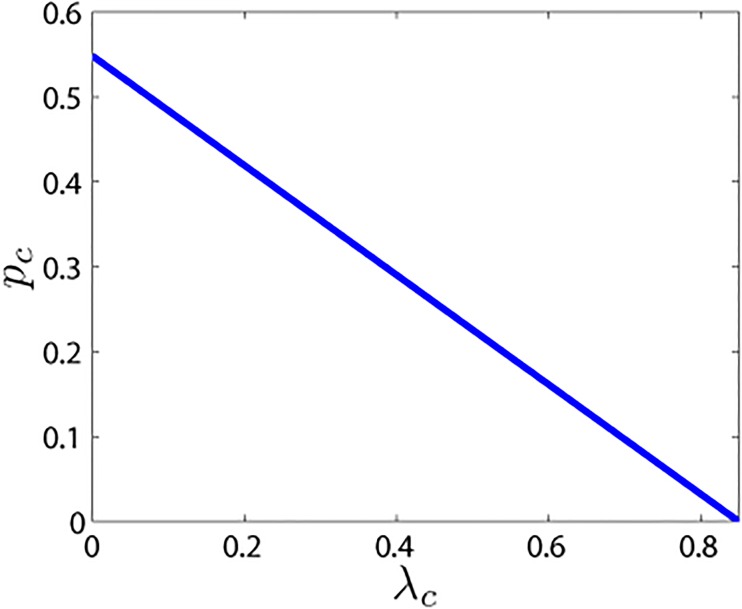
The relationship between the spread threshold (λ
c) and the immunization threshold (p
c).The parameters are λ = 0.85, θ = 0.45, α = 0.25.